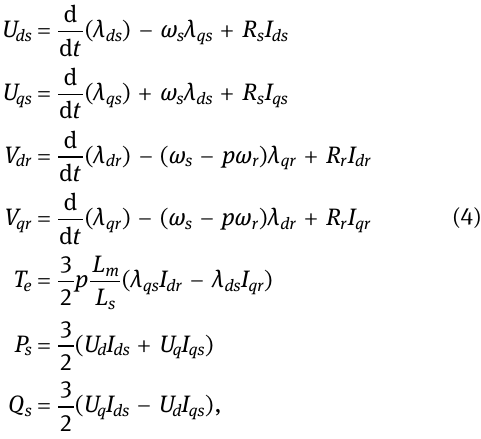
Figure 2: Block diagram for training using LM